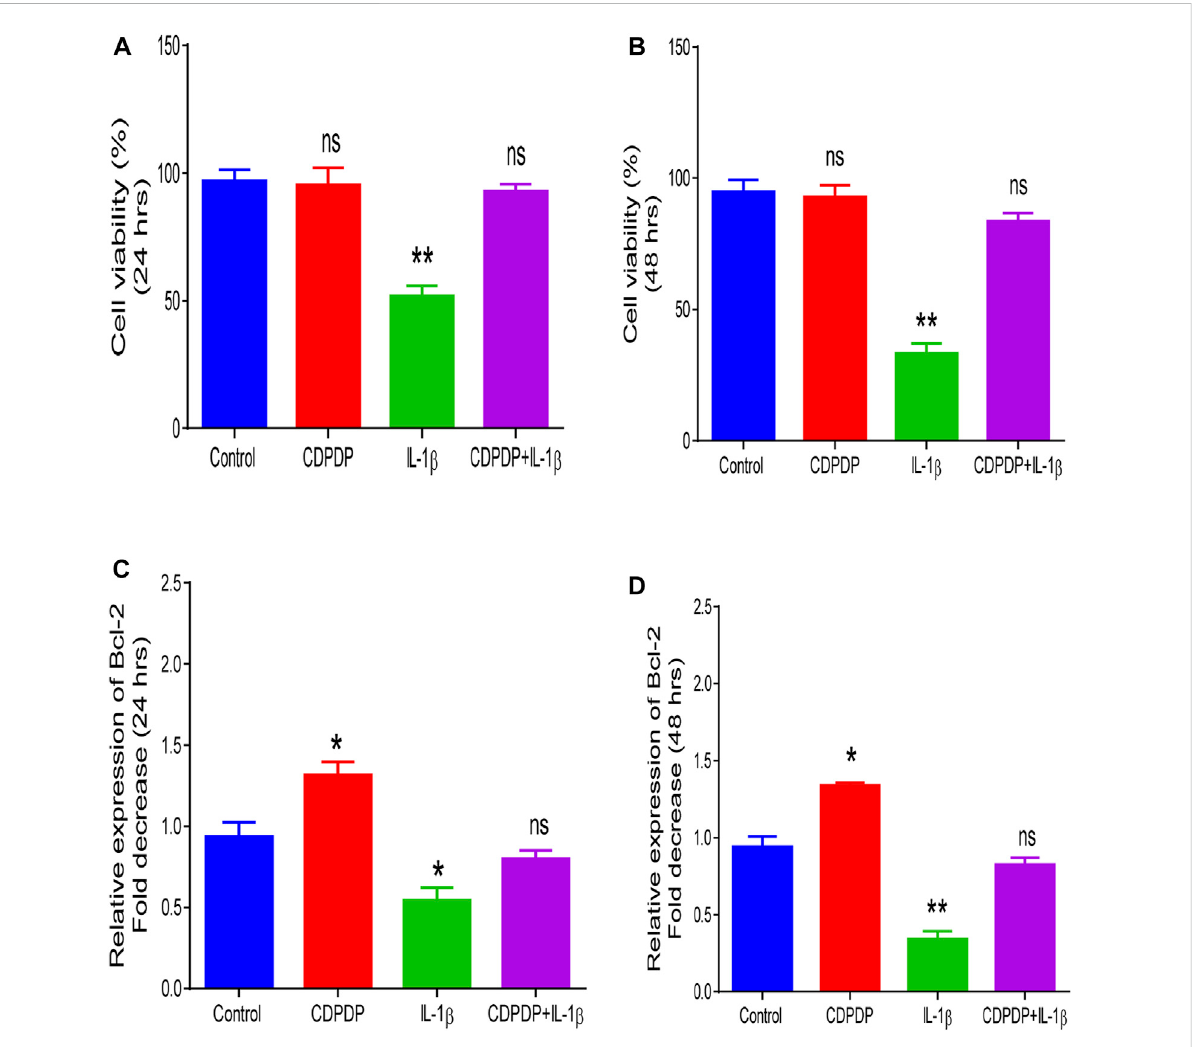
FIGURE 7 Chondrocytes werestained withtrypanbluedyeandtrypanblueexclusionmethodwasusedtoanalyze CHON-001 cellviability at24 h (A) and 48 h (B) QuantitativePCRwasperformedtomeasure (C) RelativeBcl-2expressionat24 handat (D) 48 h.Dataisshownasmean±SD( n =3).Means with different superscripts in the columns are signi fi cantly ( p < 0.05) different from one